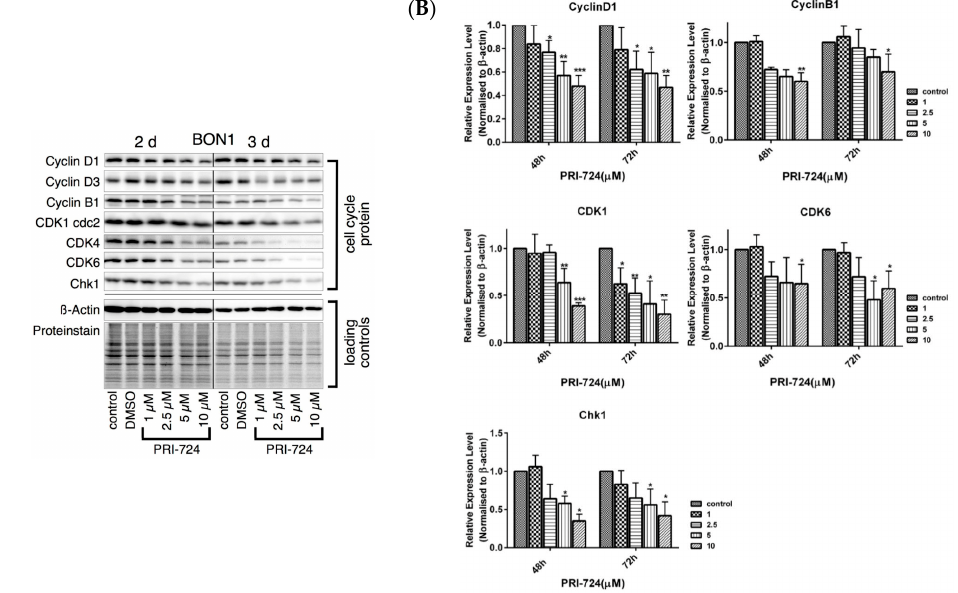
Figure 7. Effect of PRI-724 on protein expression levels of cell cycle proteins. BON1 cells were treated with PRI-724 for 48 h and 72h and then subjected to Western blot analysis. ( A ) A representative Western blot is shown. Equal protein loading was verified in all Western blots by normalization to the total protein staining and by the housekeeping protein β -actin. ( B ) Densitometric quantification of Western blot data was performed. The DMSO control was set as 1.0. Relative expression levels (normalized to DMSO control) of treated cells were calculated in %. * p < 0.05, ** p < 0.01, and *** p < 0.001 compared with that of DMSO